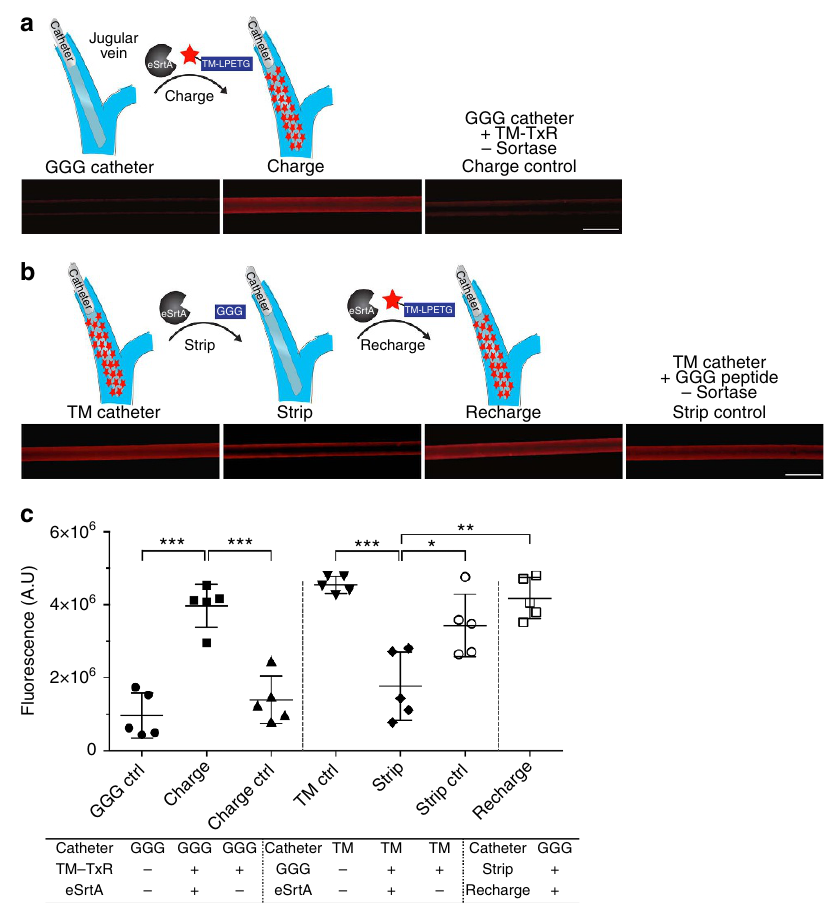
Figure 5 | In situ molecular recharging of venous catheters after in vivo deployment. ( a ) To characterize in situ charging of a chronically implanted venous catheter, pentaglycine-modified polyurethane catheters were initially deployed in the rat jugular vein for 7 days. Texas Red-labelled TM LPETG with or without eSrtA was systemically administered by intravenous injection via the dorsal penile vein. Catheters were removed 1h later and imaged using fluorescence microscopy. Representative images are shown (scale bar, 1mm). ( b ) To characterize in situ stripping, pentaglycine catheters linked to Texas Red-TM were deployed in the rat jugular vein for 7 days. GGG with or without eSrtA was delivered intravenously and 1h later catheters were removed and imaged. To examine in situ recharging, Texas Red-TM catheters were first stripped by intravenous administration of GGG and eSrtA and 24h later, Texas Red-TM LPETG and eSrtA was administered intravenously. Catheters were removed 1h later for imaging. Representative images are shown (scale bar, 1mm). ( c ) Catheter fluorescence intensity was quantified using ImageJ and plotted as. * P o 0.05, ** P o 0.01, *** P o 0.001 (Student’s t -test), error bars denote s.d. ( n Z 3). A.U., arbitrary